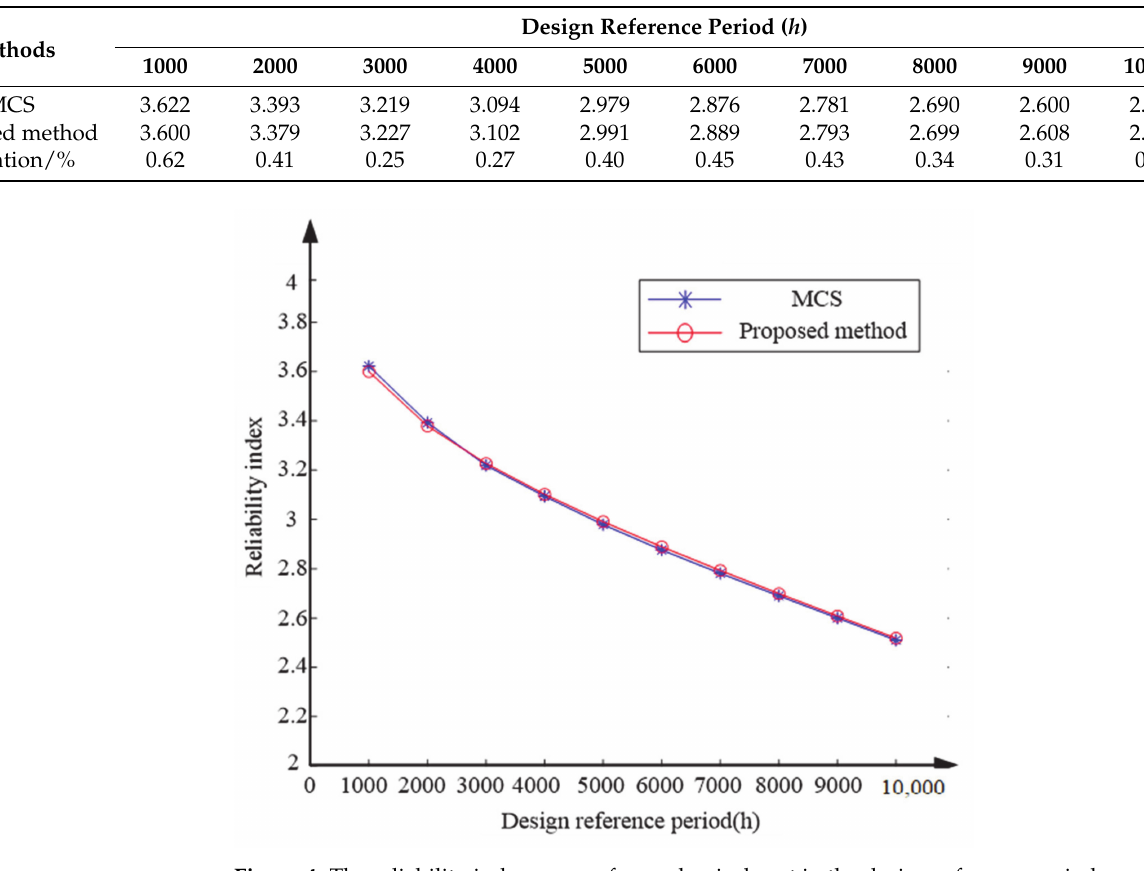
Figure 4. The reliability index curve of a mechanical part in the design reference